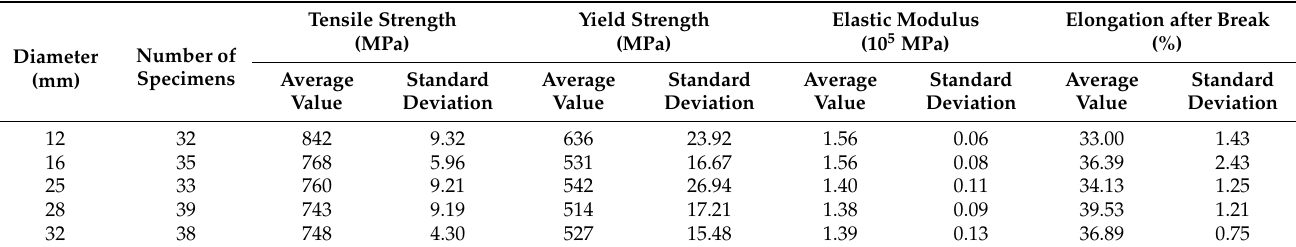
Table 3. Statistical values of mechanical indexes of duplex stainless steel bars.